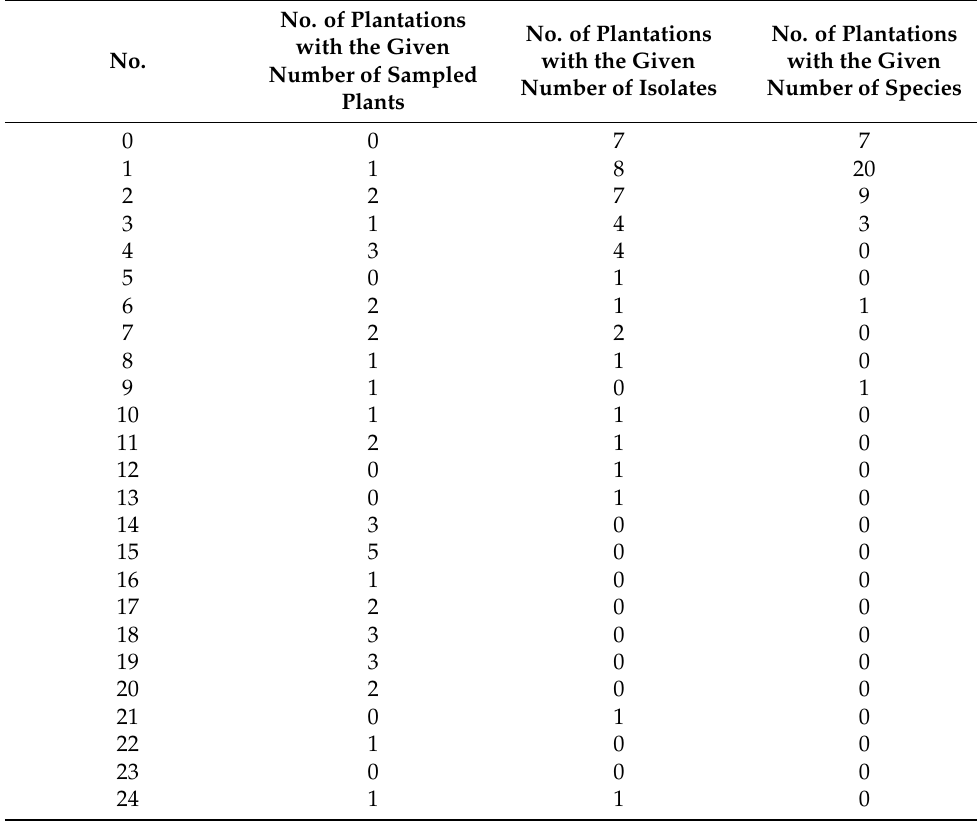
Table 3. Numbers of plant samples, isolates, and species recorded in strawberry farms in the Czech Republic.